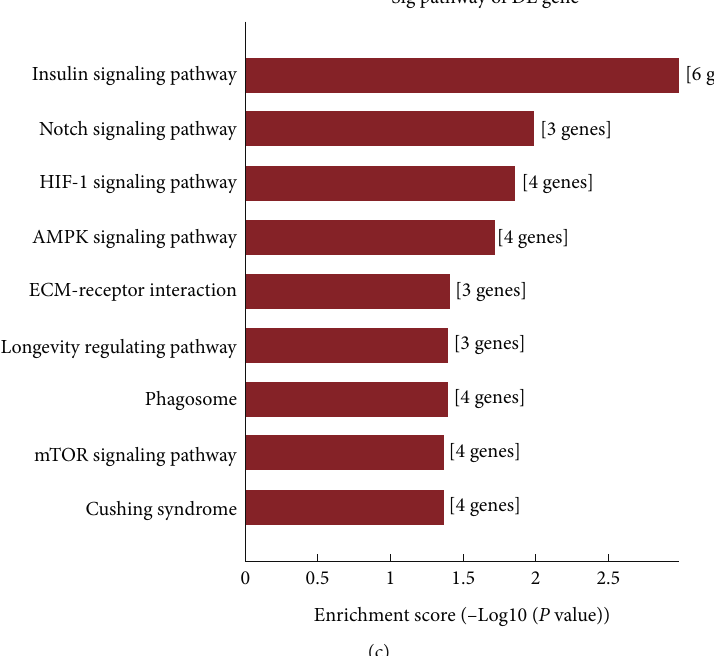
Figure 5: Functional analysis of di ff erentially methylated lncRNAs. CeRNA network with 8 signi fi cantly di ff erentially methylated lncRNAs (a). All RNAs are presented by gene symbol. Light green represents hypermethylated lncRNAs. Yellow represents hypomethylated lncRNAs. Light blue represents mRNAs. Red represents miRNAs. GO enrichment analysis (b) and pathway analysis (c) of mRNA-related lncRNAs in the ceRNA